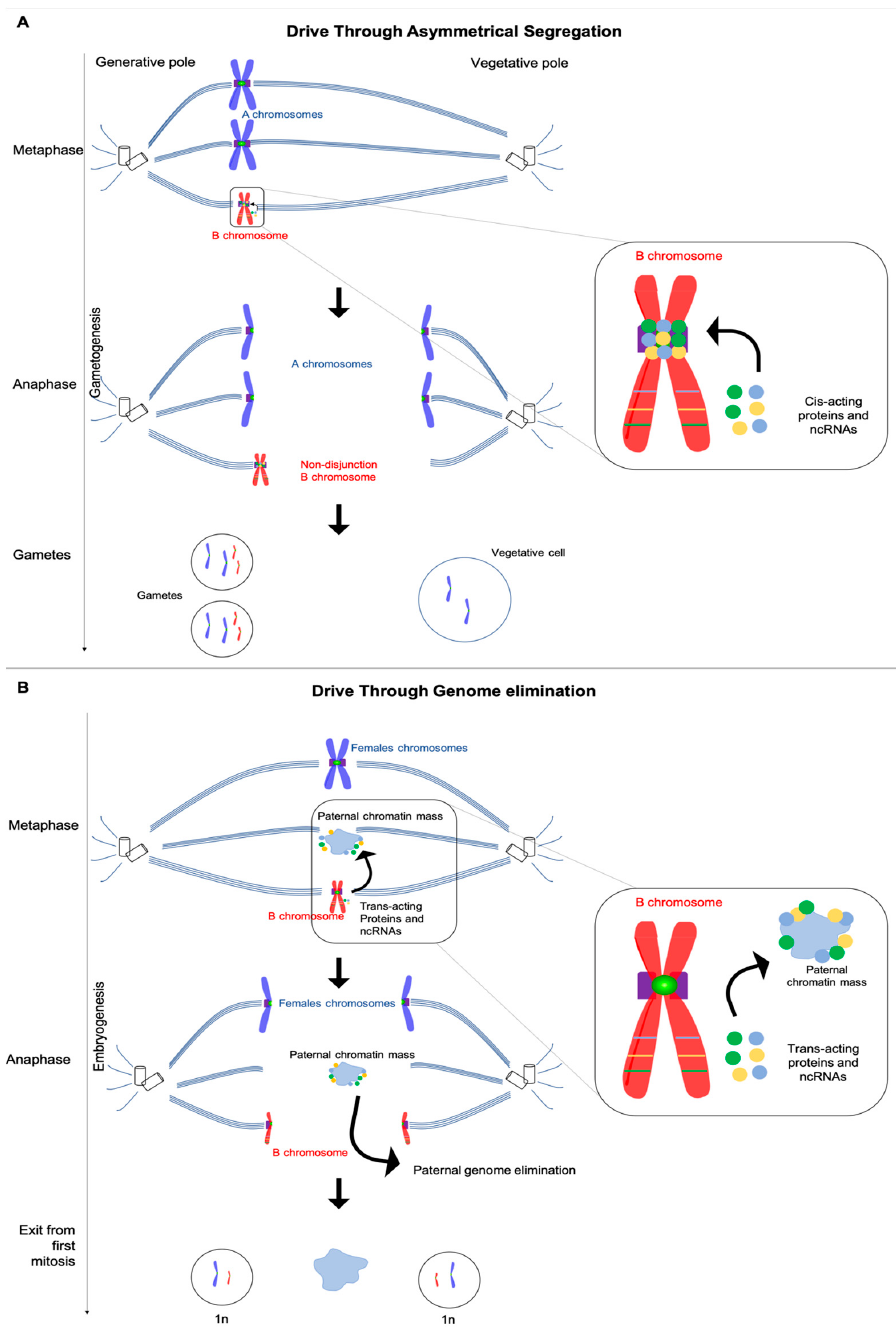
Figure 1. Possible roles for B-expressed sequences in B drive. ( a ) B chromosome drive through asymmetrical segregation and non-disjunction could involve cis-acting B specific products (proteins or ncRNAs) that retard release of the two sister chromatids at the kinetochore. The sister B chromatid pair then migrates preferentially toward the generative pole due to an intrinsic asymmetry of the spindle apparatus. As a result, multiple copies of the B chromosome accumulate in progeny over multiple generations. ( b ) B chromosome drive through genome elimination, such as occurs by the PSR chromosome in the jewel wasp Nasonia vitripennis , occurs during the first mitotic division of the newly fertilized embryo. In this model, B-chromosome-expressed protein or RNA could localize preferentially with the paternal chromatin, recruiting chromatin-remodeling enzymes that disrupt normal chromatin remodeling dynamics through abnormal histone modification. As a consequence, the paternal chromatin forms a condensed mass that is unable to resolve into chromosomes and segregate properly.